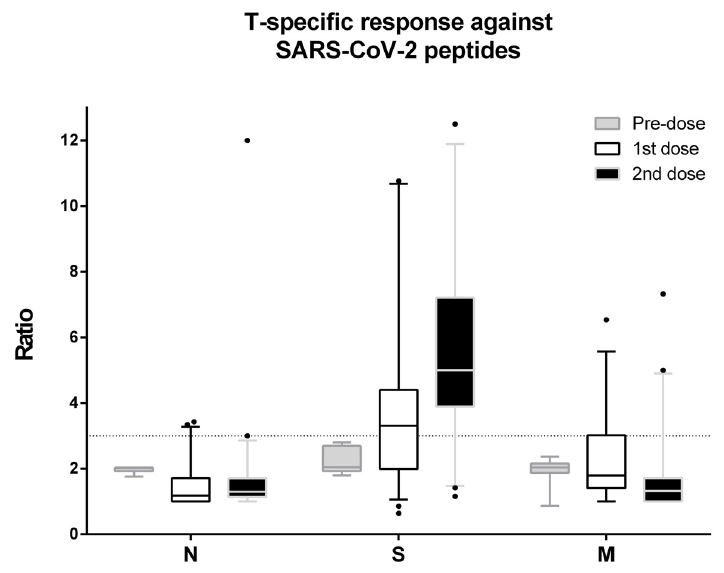
Figure 5. The ratio of specific CD4 + CD25 + CD134 + cells after Nucleocapside-pool (N), Spike-pool (S), and Membrane-pool (M) of SARS-CoV-2 peptide stimulation is shown. Grey (before immunization), white (after the first dose), and black (after the second dose) whisker-box plots are shown, and the cutoff to consider T-specific positive response was set at ratio >3 (dotted line).